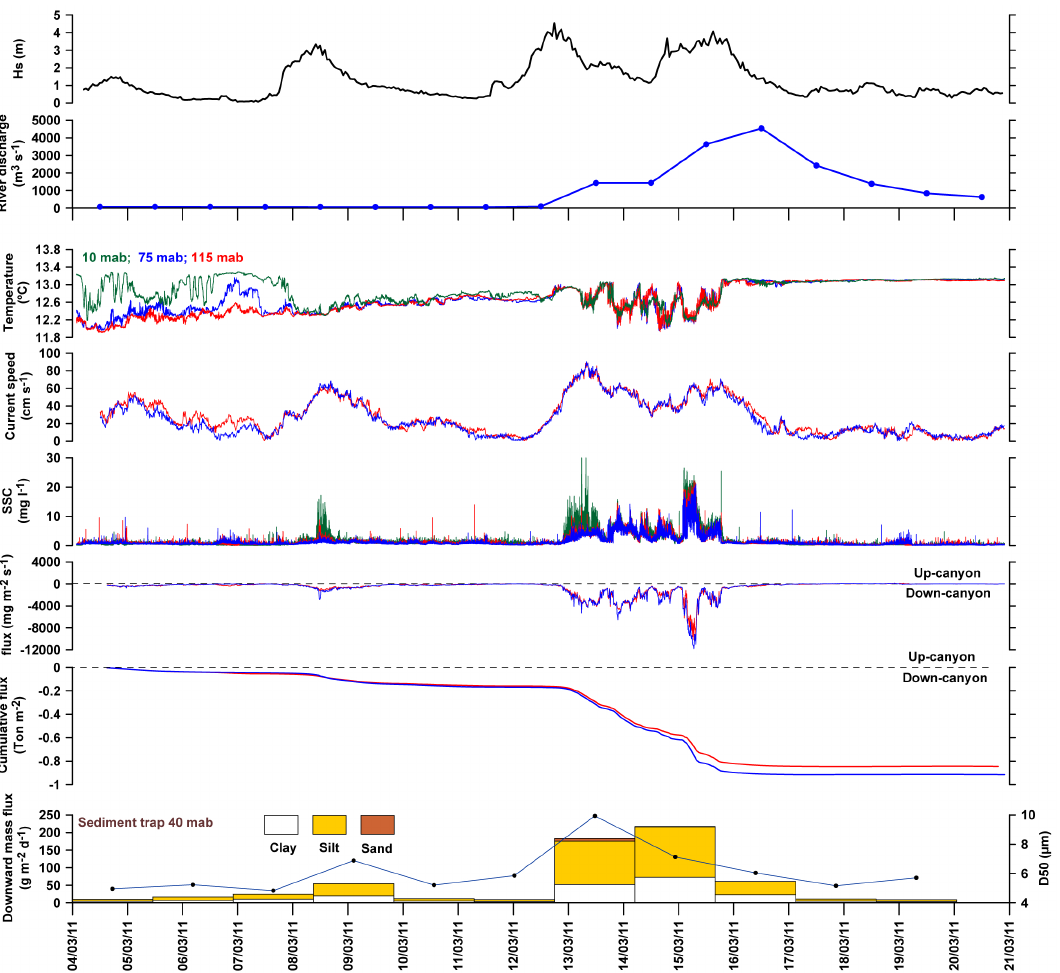
Fig. 8. Time series of water and sediment fluxes in the Cap de Creus south canyon wall (mooring SF2, see Fig. 1b for location). From top to bottom: significant wave height measured at the POEM site; total river discharge from coastal rivers opening to the Gulf of Lion (i.e. excluding the Rhˆone); in situ water temperature (measured by 3 Seapoint Aqualoggers), current speed measured by the ADCP at Seapoint depths, suspended sediment concentration (Seapoint), and sediment flux rotated to meet the main canyon axis (negative values are down-canyon); cumulative transport calculated from the precedent flux; downward particle flux estimated from a sediment trap at 40mab in the same mooring line. Trap fluxes are itemized in three major grain-size classes (clay, silt, sand); the median of the grain-size distribution (d50) is also